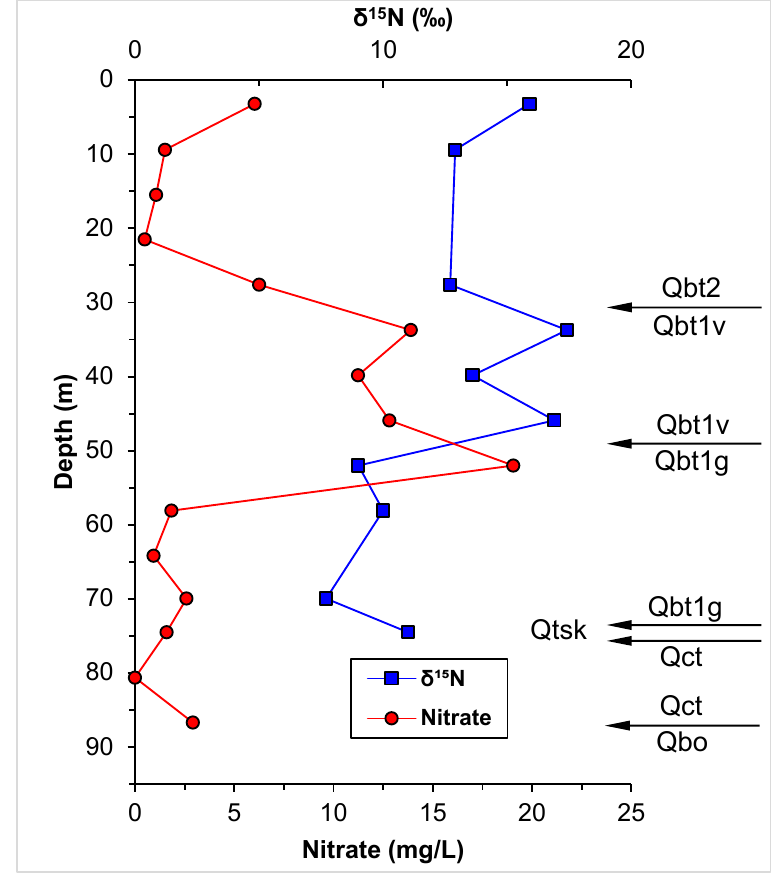
Figure 13. Comparison of δ 15 N and nitrate profiles in Borehole 7.